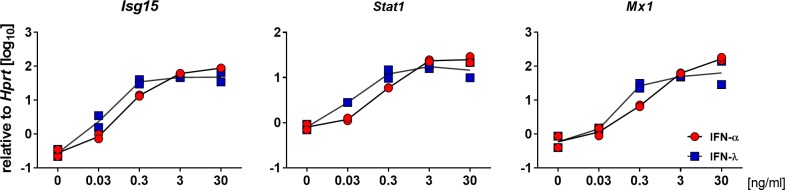
IFN-λ and IFN-α have comparable potency on primary airway epithelial cells.The biological activities of IFN-α and mouse IFN-λ preparations were determined by stimulating primary AEC cultures for 4 hr with the indicated concentrations of these cytokines. Induction of the IFN-stimulated genes Isg15, Stat1 and Mx1 was assessed by RT-qPCR; values are represented as gene expression levels relative to Hprt. Representative data of two independent experiments is shown.